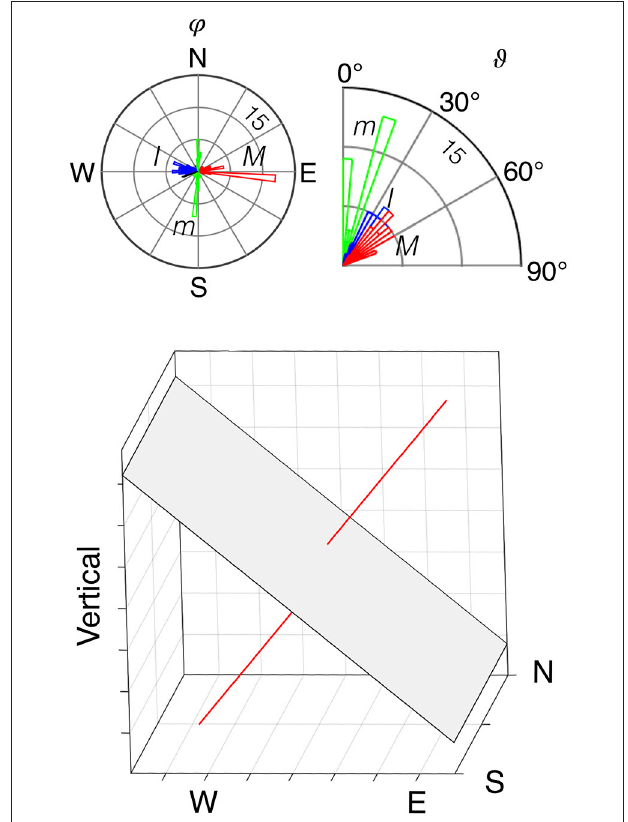
FIGURE 9 | Eigenvector statistic for the unconstrained MT inversion solution. The smallest ( m ), intermediate (I ), and largest ( M ) eigenvectors are shown by green, blue, and red bins, respectively. φ is the azimuth, measured clockwise from north and ϑ is the inclination angle, measured from the vertical. The orientation of the crack plane and its normal (maximum eigenvector) are also shown in the xyz coordinate